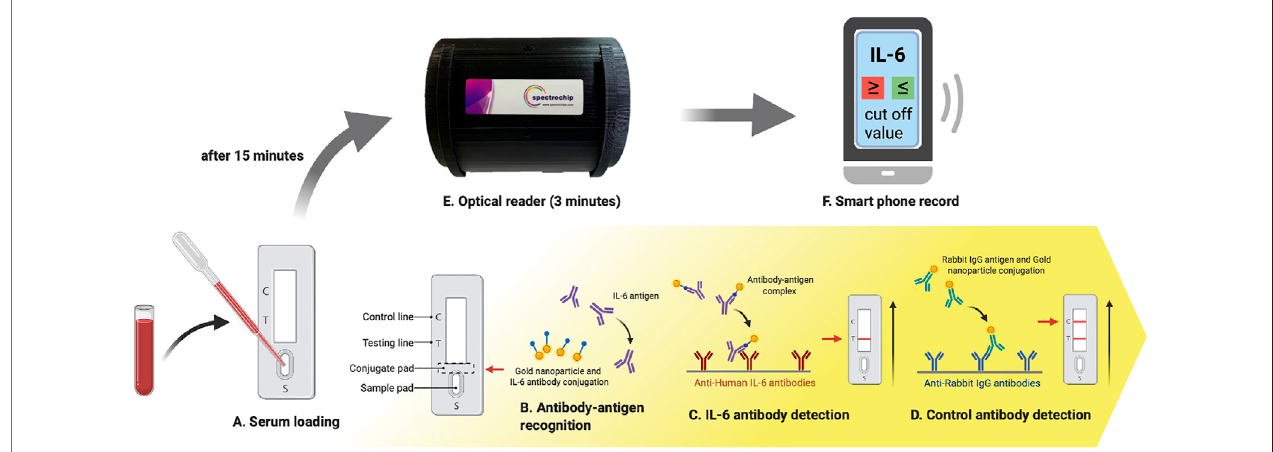
FIGURE 4 | The IL-6 test strip work fl ow coupled with a spectrum-based optical reader. This new spectrum analyzer platform system requires only 0.1 ml of blood serum to be added to the test strip, and provides results in 15 min. The test strip is placed in a spectrometer for quantitative spectral analysis. This scan